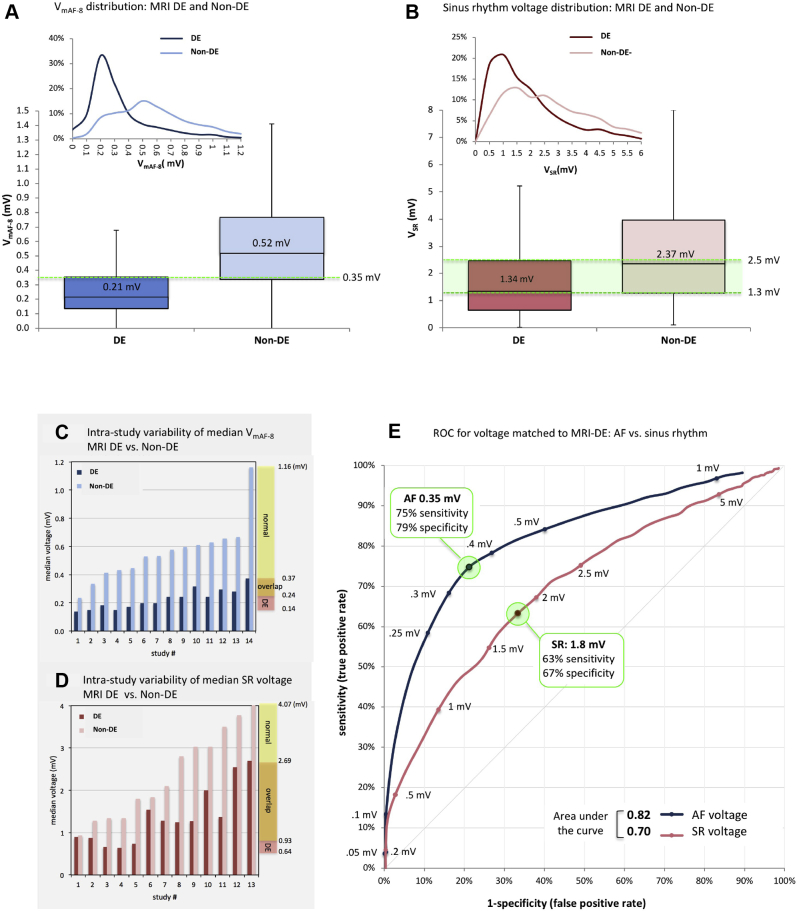
Distributions of 8-second mean atrial fibrillation(AF) and sinus rhythm (SR) voltage in delayed enhanced (DE) vs non–delayed enhanced (non-DE) subregions. A: Global distribution of VmAF-8 in DE vs non-DE subregions. B: Global distribution of VSR in DE vs non-DE subregions. C: Intrastudy variability of median VmAF-8 in DE vs non-DE subregions across patients. D: Intrastudy variability of median VSR in DE vs non-DE subregions across patients. E: Receiver operating characteristic (ROC) curves for respective AF and SR voltage match to delayed-enhancement magnetic resonance imaging (MRI-DE).